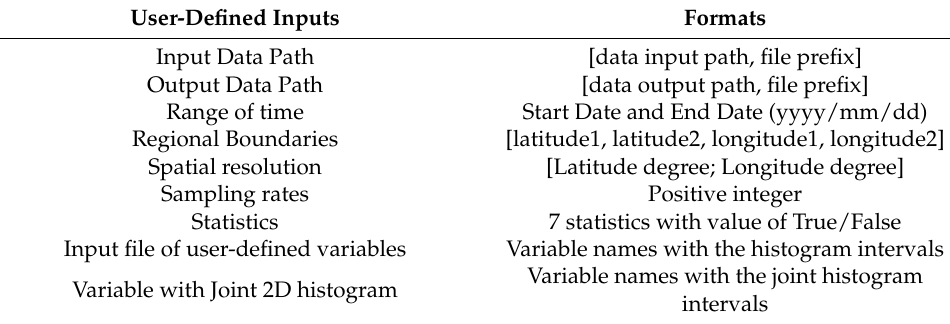
Table 1. The inputs that users can define in the aggregation